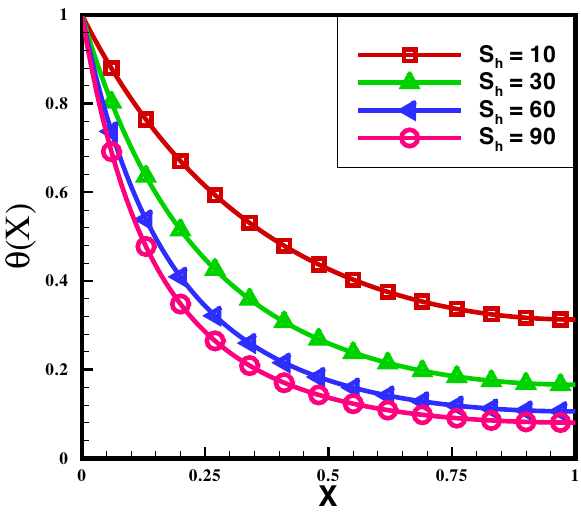
Figure 2. Effect of S h on temperature distribution.